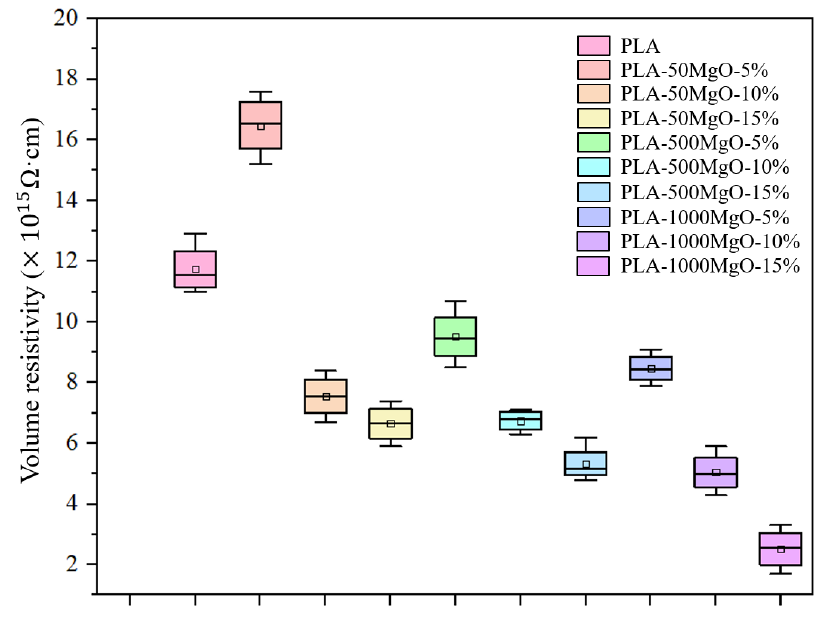
Figure 7. Resistivity of different PLA composites.